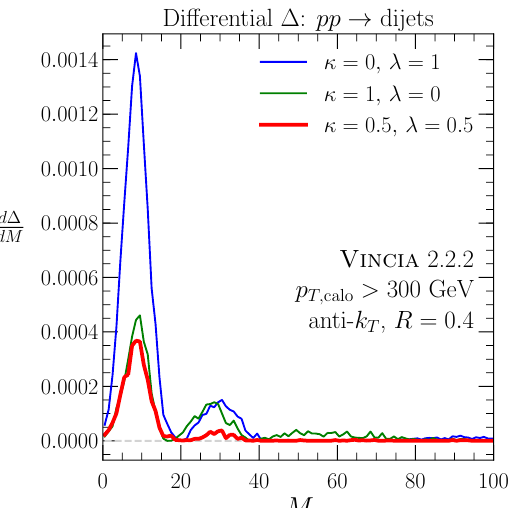
Figure 6 . Di(cid:11)erential contributions to (cid:1) as a function of M for the three GTAM variants in (cid:12)gure 4(a). The choice ( (cid:20); (cid:21) ) = (0 : 5 ; 0 : 5) minimizes d(cid:1) = d M across the non-perturbative, resum- mation, and (cid:12)xed-order